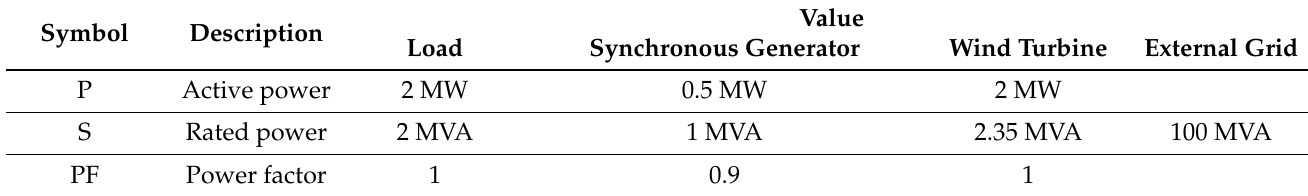
Table A1. Main parameters of the test case of Figure 4.